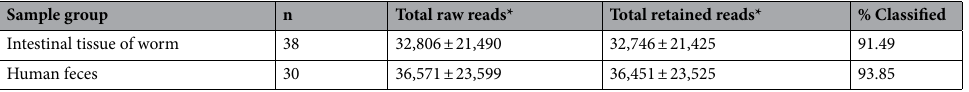
Table 1. Sequencing summary of 16S bacteriome in each group. *Data shown in table were presented as mean ± SD.